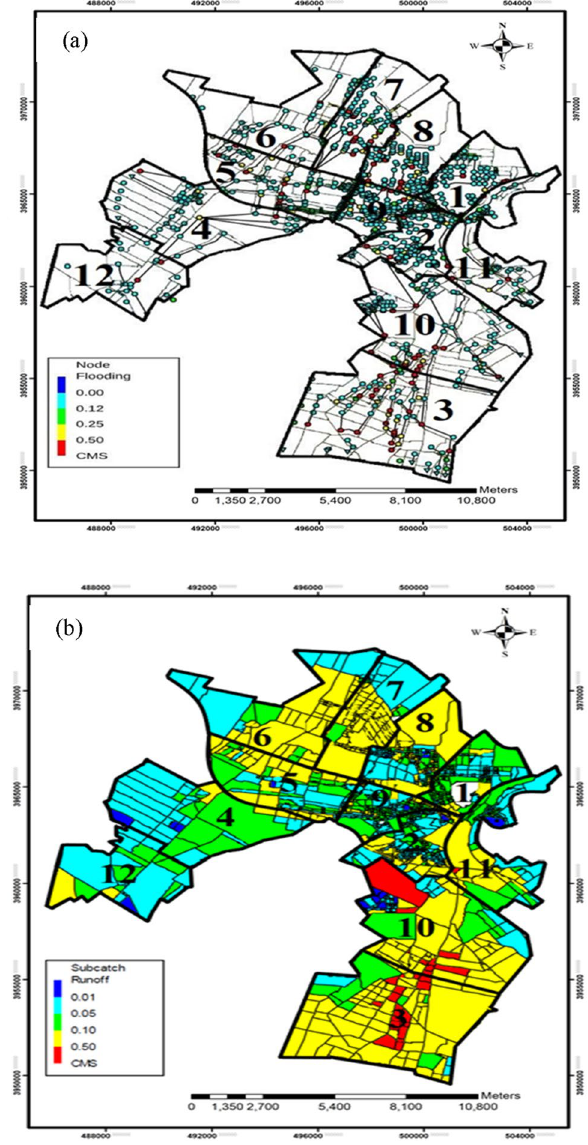
Figure 3. Map of ( a ) flooding in different nodes and ( b ) runoff in different sub-catchments (This figure was created in the Quantum GIS, version